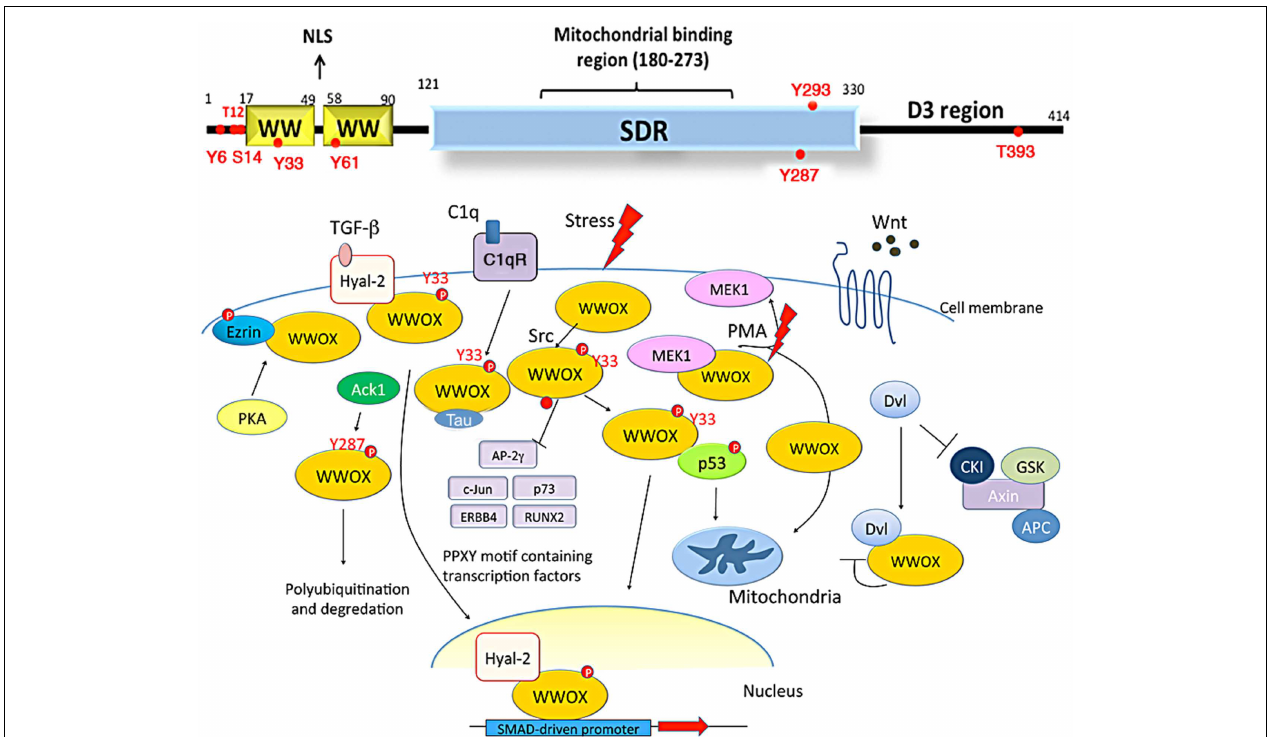
ERBB4, via its firstWW domain, and the binding blocks the activity of these proteins by retaining them in the cytoplasm.WWOX bindsTau via its SDR domain.WWOX participates in theWnt/ β -catenin signal pathway by binding Dvl and inhibiting its nuclear import. Phorbol ester stimulates the dissociation of MEK/WWOX complex in JurkatT cell, and the releasedWWOX translocates to the mitochondria for causing cell death.WWOX is recruited to the membrane area by association with Hyal-2 and phospho-Ezrin. Hyal-2 is an alternative receptor forTGF- β 1. In response toTGF- β 1,WWOX binds Hyal-2 and forms a complex, followed by relocating to the nucleus and enhancing the SMAD-driven promoter activity. Ack1, activated Cdc42-associated kinase 1; Hyal-2, hyaluronoglucosaminidase 2; CKI, casein kinase; GSK, glycogen synthase kinase; PKA, protein kinase